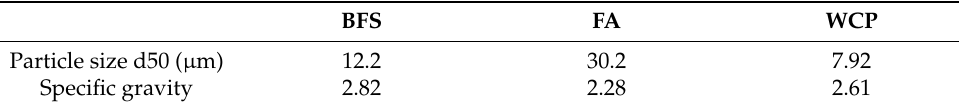
Figure 2. XRD patterns of BFS, FA, and WCP. Table 2. Physical properties of BFS, FA and